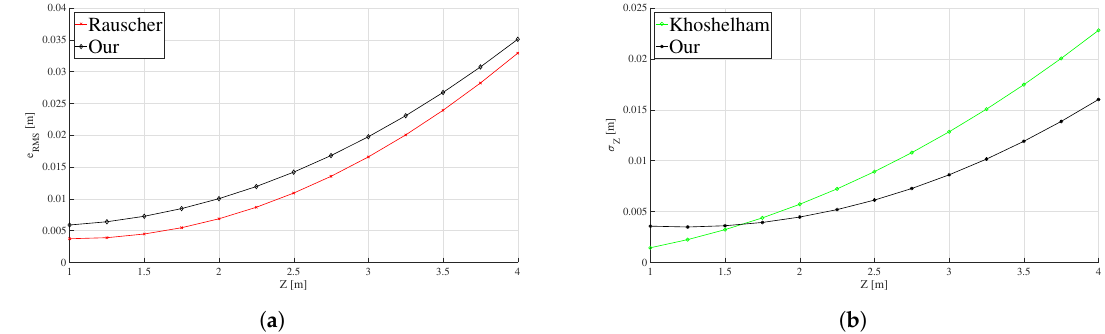
Figure 5. Comparison between methods to estimate the depth error in the Kinect v1. ( a ) Comparison of our method with Rauscher approach [2], using the results of the depth error in terms of RMS ( e RMS ), and ( b ) comparison of our proposal with Khoshelham approach [5] using the standard deviation ( σ Z ) to represent the error.